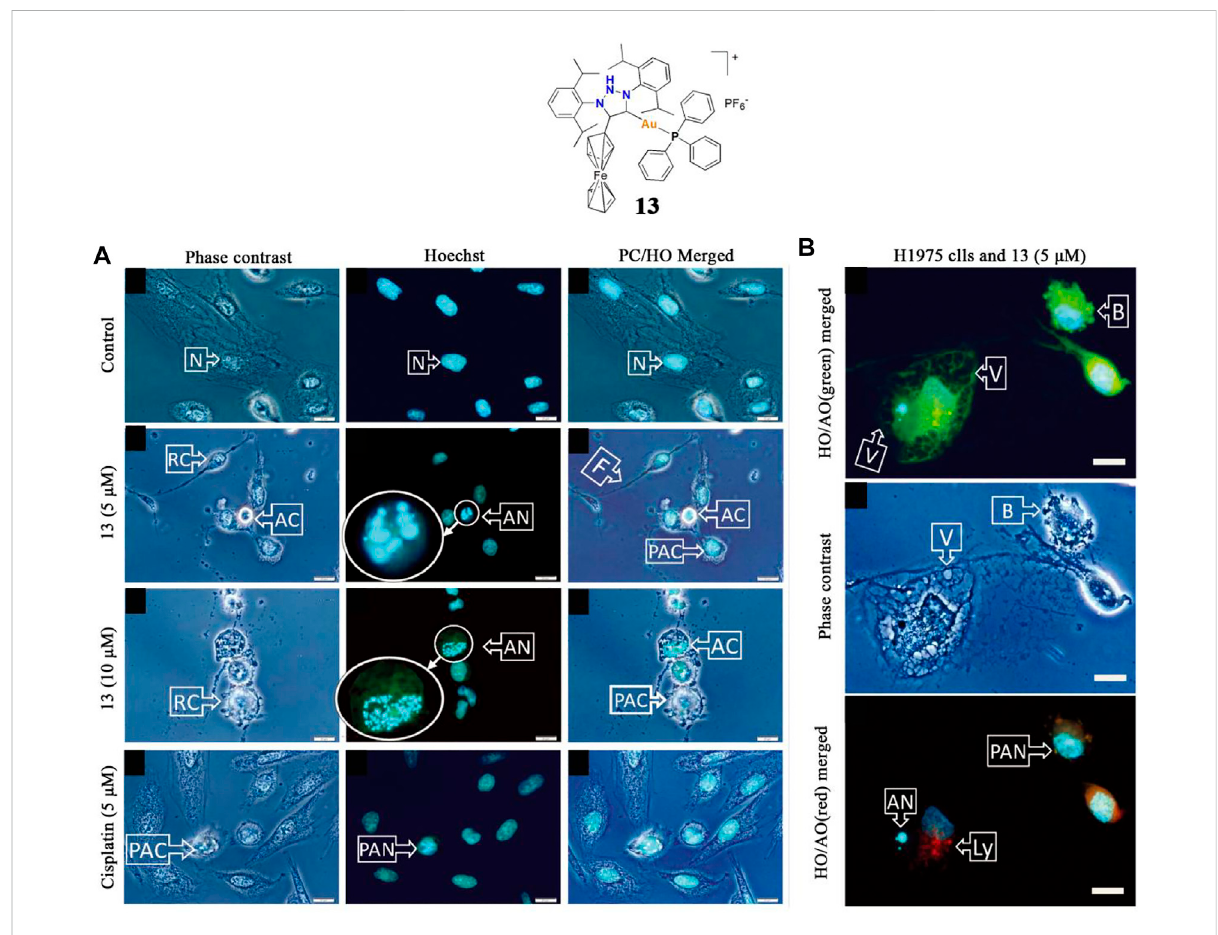
FIGURE 7 (A) Lung cancer cells H1975 undergo apoptosis after being treated with complex 13 at 5/10 μ M concentrations for 18 h (B) Microscopic evaluation ofH1975 cellmorphology aftertreatmentwith complex 13 ata5 μ Mconcentrationfor 18 h.Reproducedwithpermission (Bezuidenhout et al.,